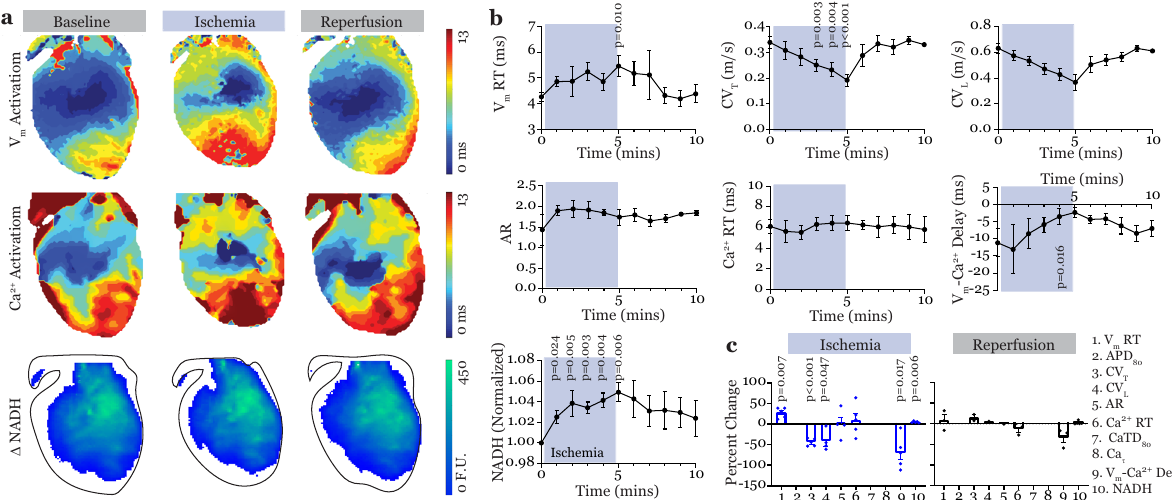
Fig. 4 Triple-parametric optical mapping in cardiac disease assessment. a Representative V m activation maps (top), Ca 2 + activation maps (middle), and NADH intensity maps (bottom) were recorded from the same mouse heart during baseline, ischemia, and reperfusion conditions. All maps in a given column were obtained by simultaneous imaging. b Summary of seven parameters measured over time, simultaneously by triple-parametric optical mapping. Three parameters — APD 80 , CaTD 80 , and Ca 2 + decay were not measurable due to motion artifacts in the repolarization phase due to absence of electromechanical uncoupling. The values reported are normalized to baseline ( t = 0) for each heart in order to determine modulation of each parameter in each heart with respect to its own baseline condition. c Ten-parameter panels (only seven parameters reported) demonstrating changes in cardiac physiology during ischemia and restoration during reperfusion. Data are presented as mean ± s.e.m., n = 5 hearts. Two-tailed, paired t -tests were performed to detect signi fi cant change induced by ischemia and reperfusion compared to baseline and all signi fi cant p values are reported. Benjamini – Hochberg correction was applied to account for multiple